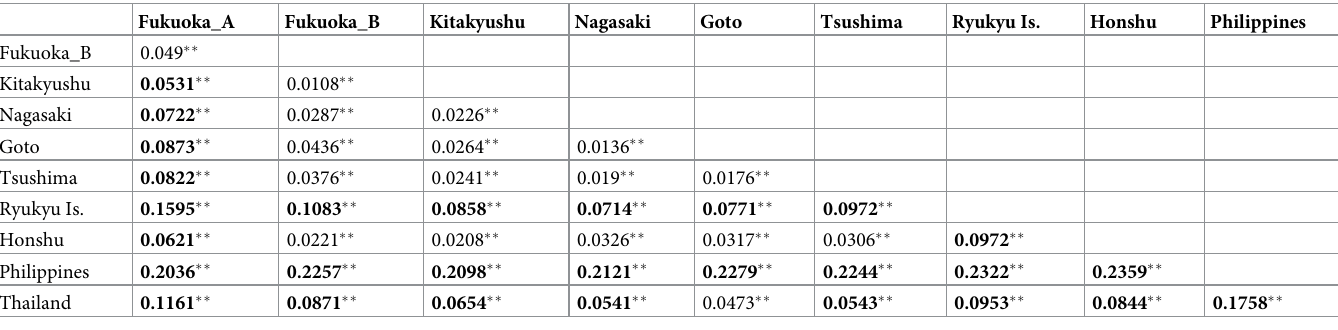
Table 6. Pairwise fixation index values (F st ) between ten Ae . albopictus groups consisting of Kyushu, Honshu, and two tropic populations. Fukuoka_A